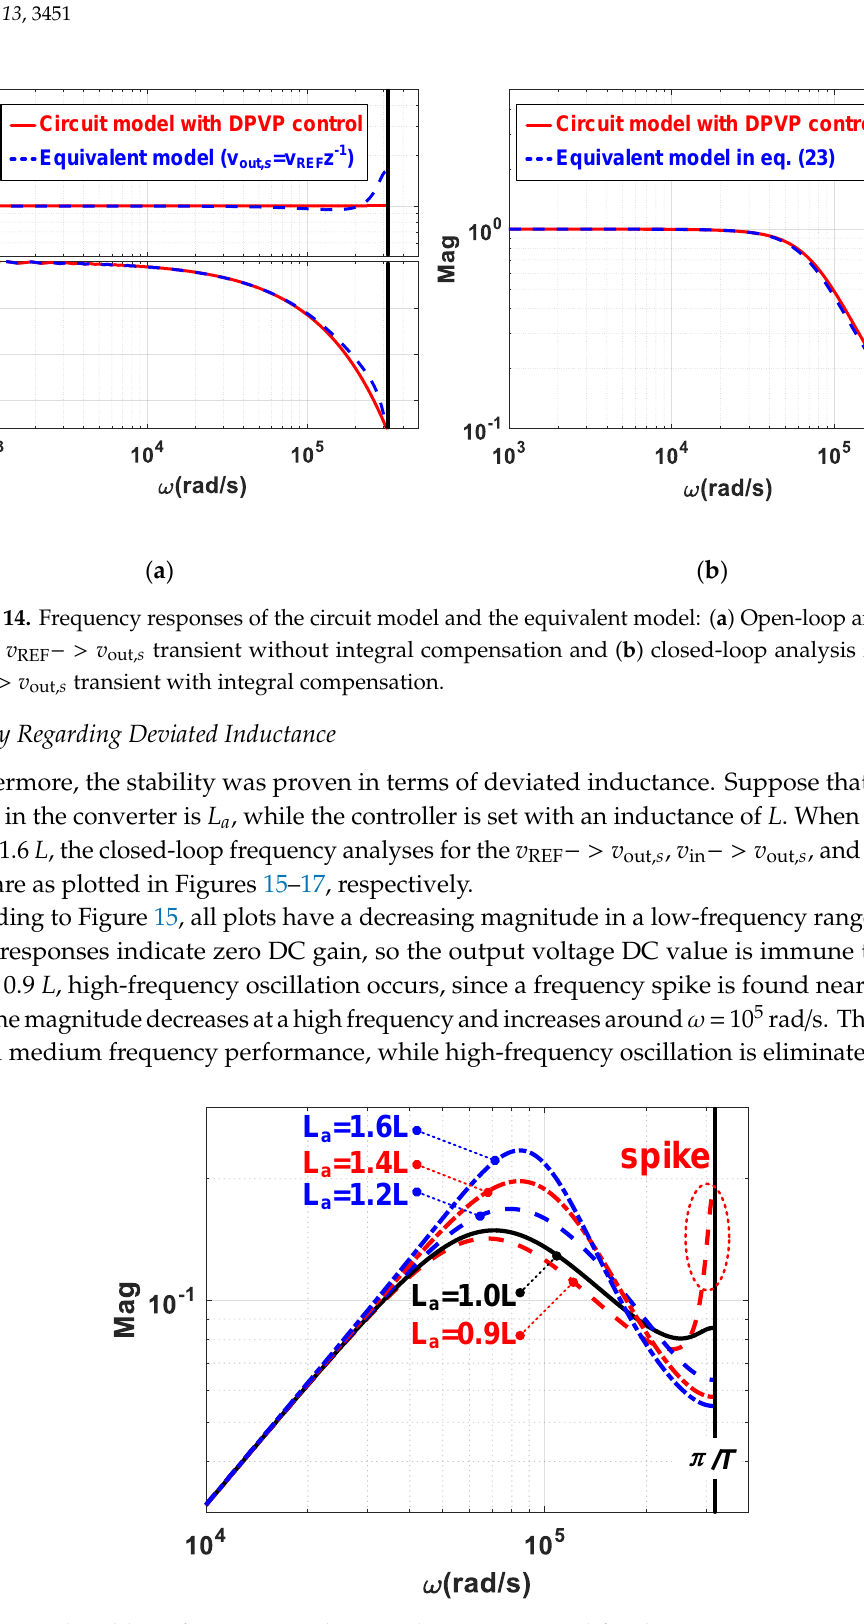
Figure 15. Closed-loop frequency analyses under DPVP control for the R -> v out, s transient with deviated inductance.